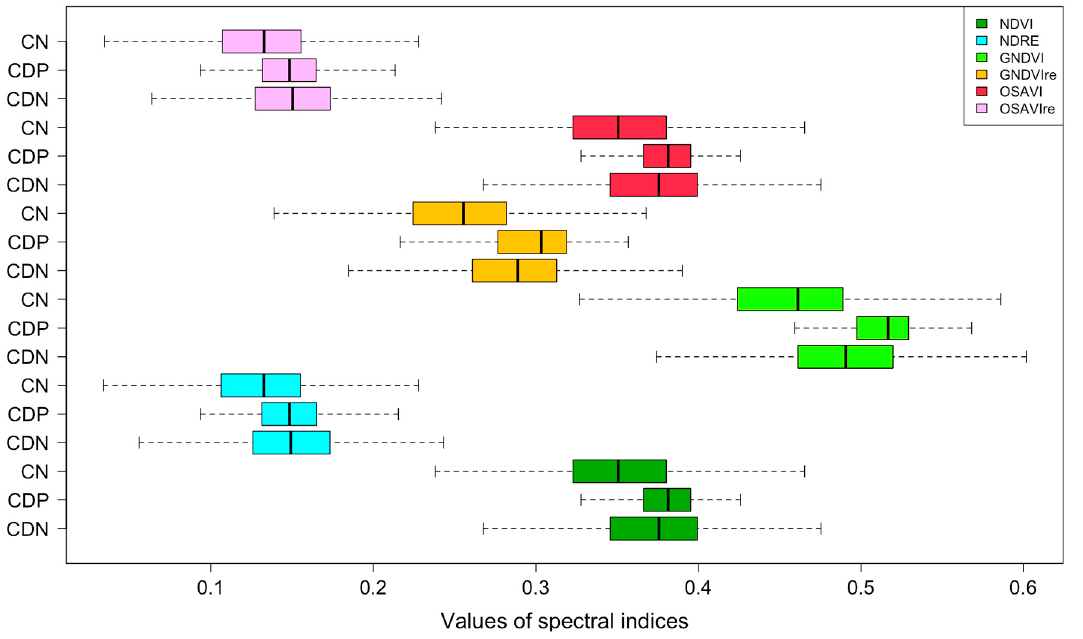
Figure 6. Scatter plot of the analysed spectral indices for the three types (CDN, CDP, and CN) of bioreactor compartments.